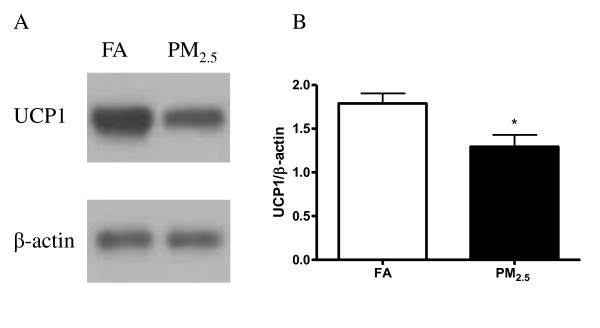
PM2.5 exposure decreases UCP1 protein in the iBAT evaluated by Western blot. A. Representative bands of FA and PM2.5 on UCP1 protein level in iBAT by Western blotting. B. Quantitative results of Western blotting of UCP1. n = 8. *P <0.05 vs. FA.